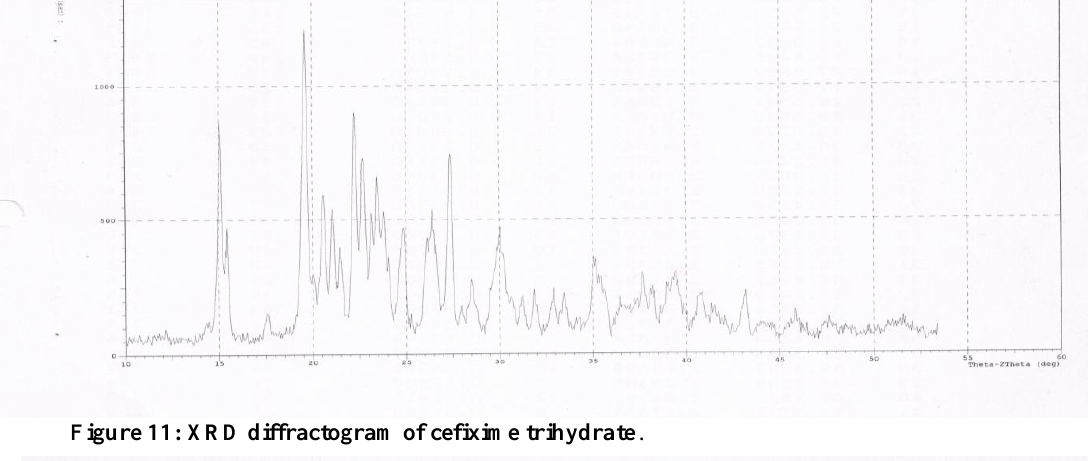
Figure 11: XRD diffractogram of cefixime trihydrate .